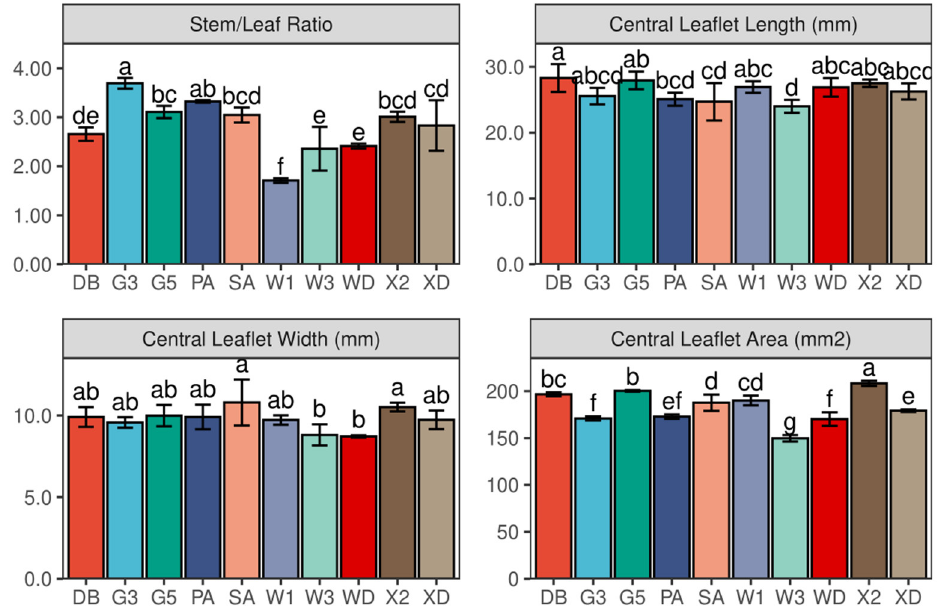
Figure 7. Stem/Leaf Ratio and central Leaflet Length, Width, and Area at flowering (first cutting) in 2017. Different letters indicate means that are significantly different at p < 0.05. Error bars indicate the standard deviation of the means. DB: Derby, G3: Gannong No. 3, G5: Gannong No. 5, PA: Phabulous, SA: Sanditi, W1: WL168HQ, W3: WL343HQ, WD: Wudi, X2: Xinmu No. 2, XD: Xinjiang Daye.